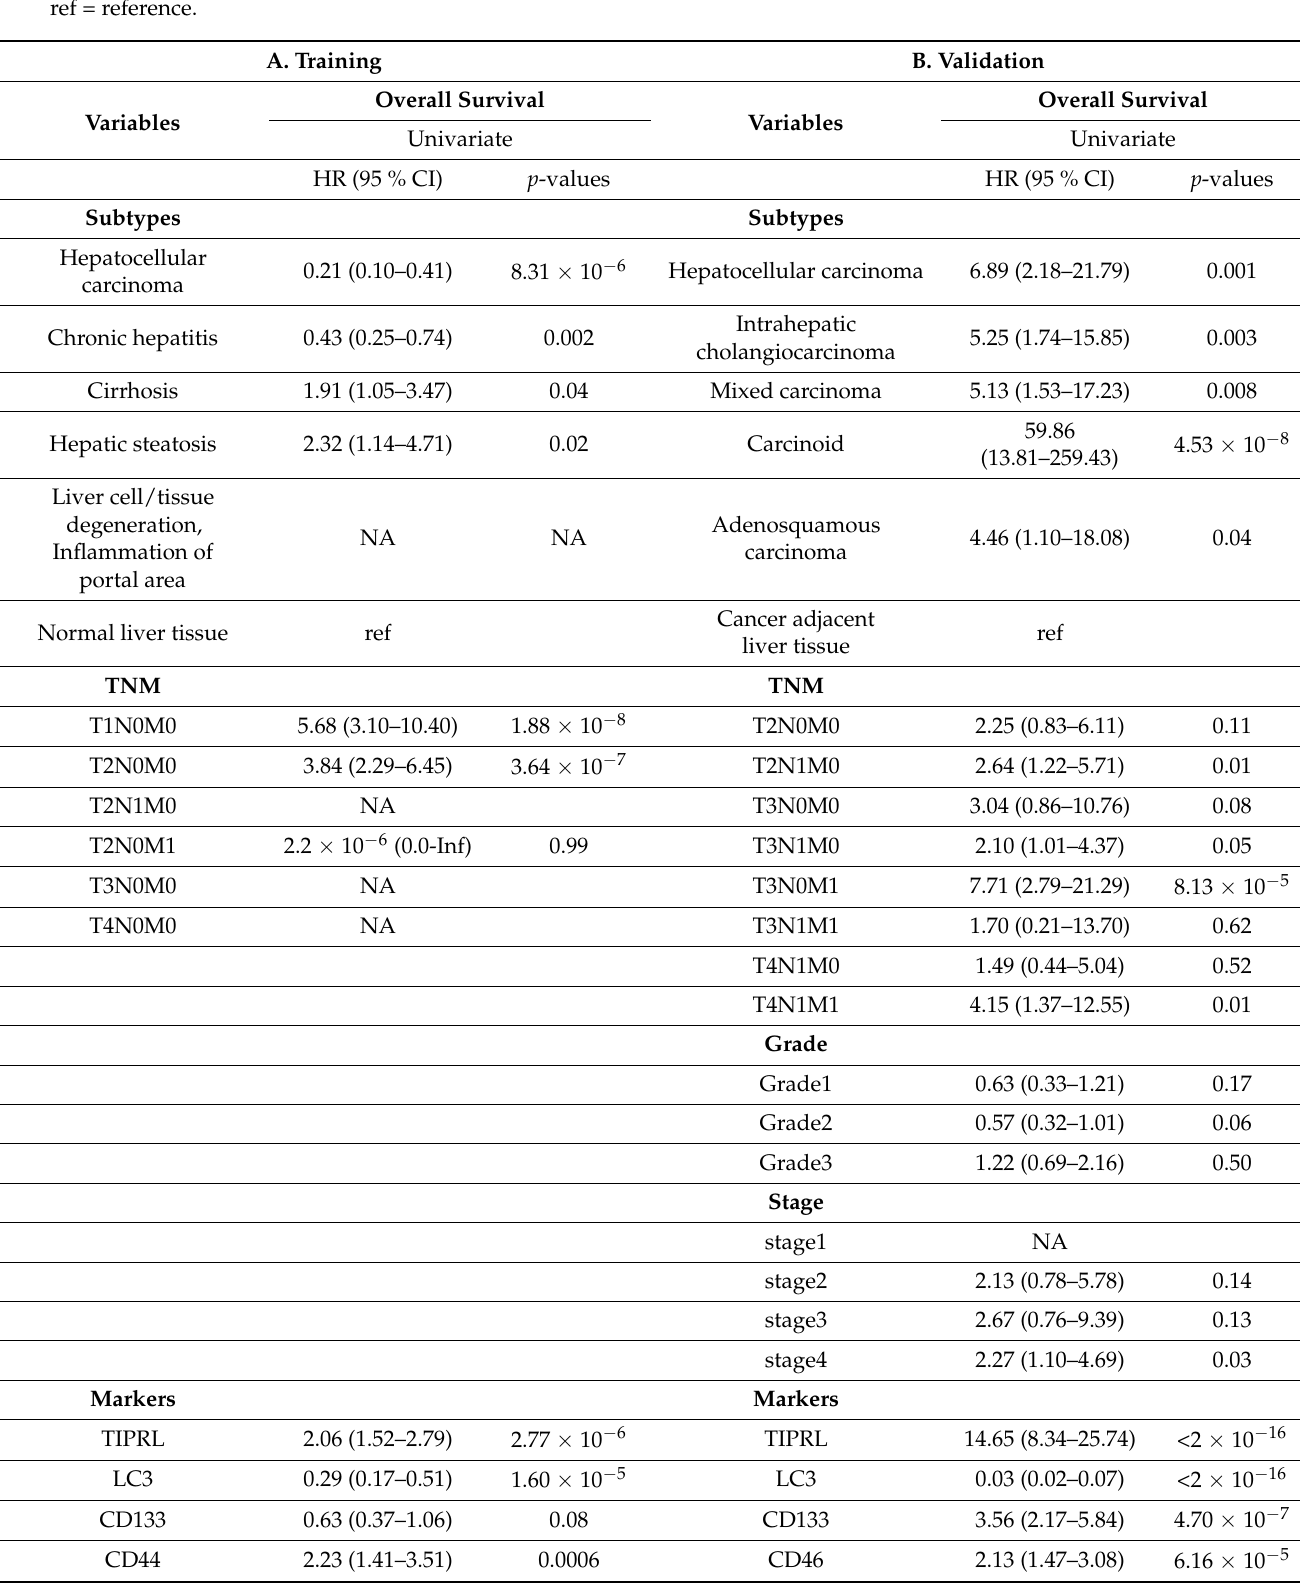
Table 2. Multivariate analysis of overall survival of liver disease patients according to potential prognostic variables multivariate analysis of overall survival of liver disease patients according to the significant prognostic variables on univariate analysis in the training (A) and the validation (B) set. Abbreviations: HR = hazard ratio; CI = confidence interval; ref =